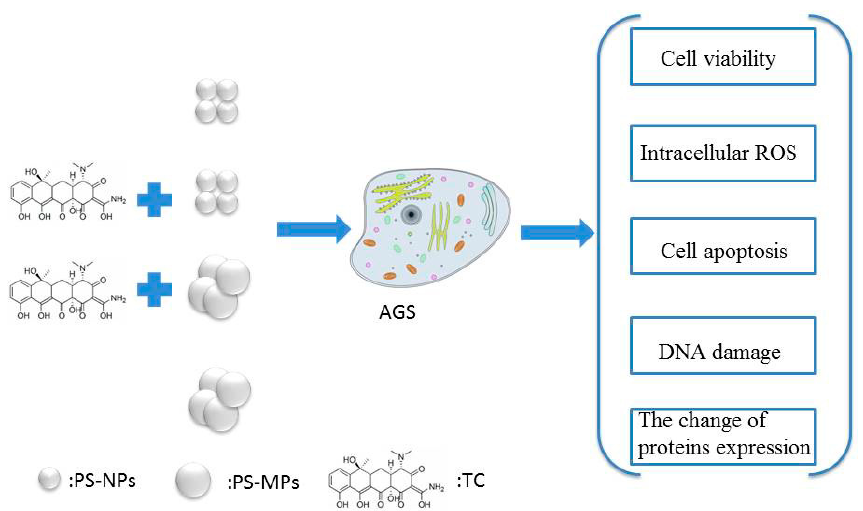
Figure 1. The experimental schematic. Abbreviations including Tetracycline (TC), polystyrene microplastics (PS-MPs) and polystyrene nanoplastics (PS-NPs).